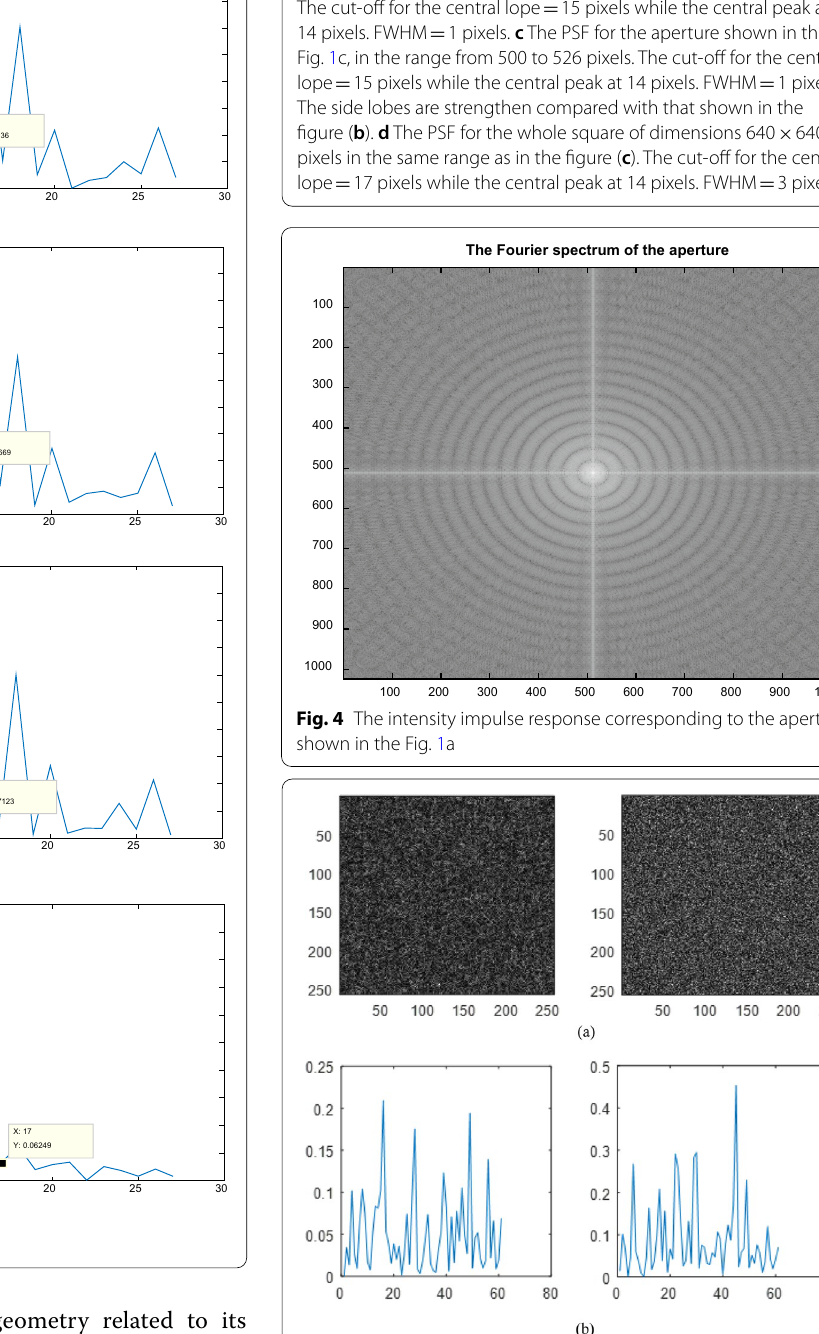
Fig. 5 a In the L.H.S., speckle image in presence of the aperture shown in the Fig. 1a, while in the R.H.S., speckle image in absence of the aperture is shown. b In the L.H.S., speckle plot in presence of the aperture, while in the R.H.S., speckle plot in absence of the aperture is shown. The range is from 60 up to 120 pixels.